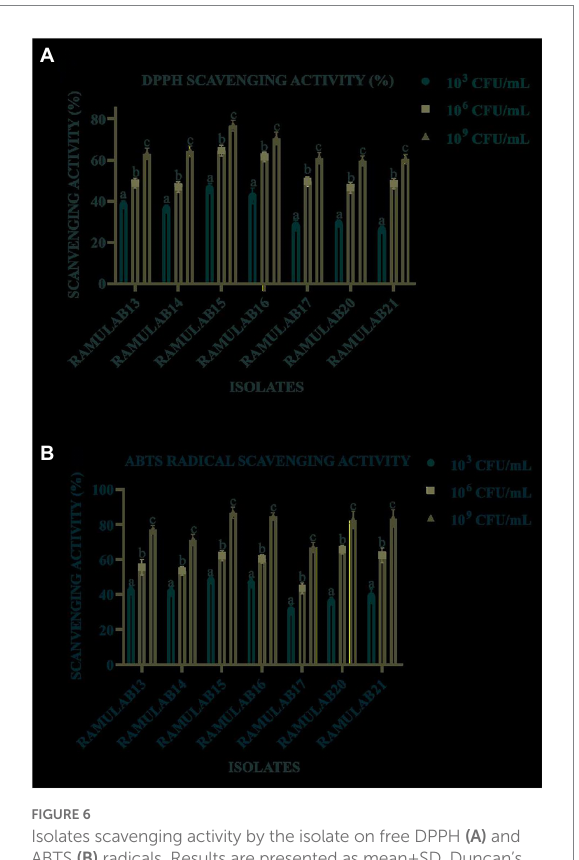
FIGURE 6 Isolates scavenging activity by the isolate on free DPPH (A) and ABTS (B) radicals. Results are presented as mean ± SD. Duncan’s multiple range test shows that the means of the same column that are denoted by different letters (a–d) are substantially different ( p ≤